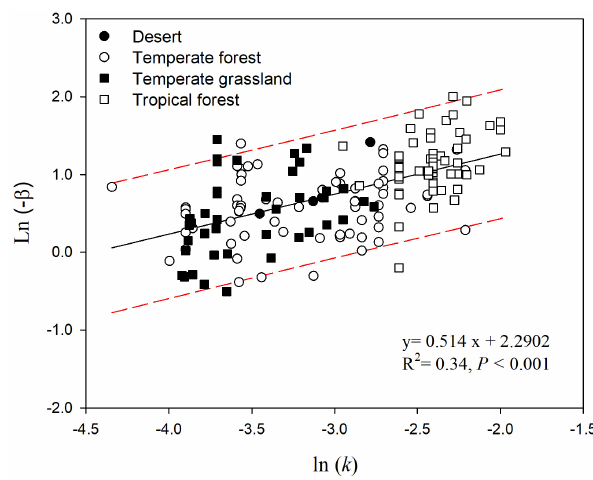
cause the model has been widely tested and accepted (Har-